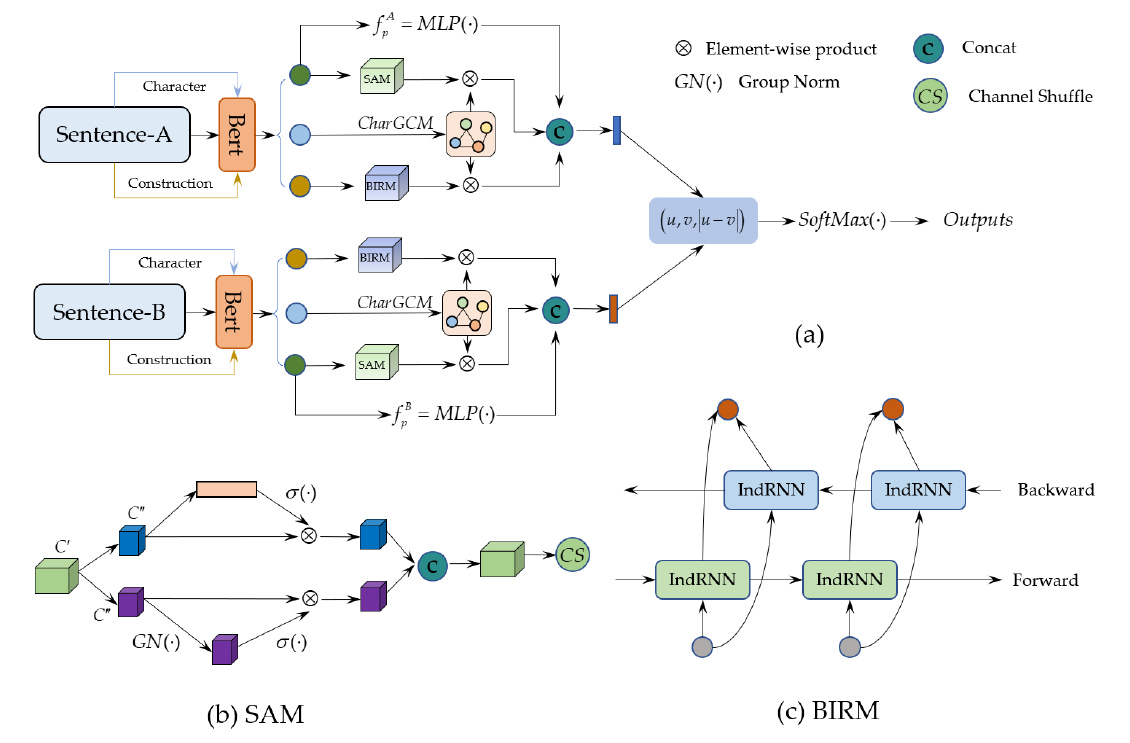
Figure 1. ( a ) The overall network structure of CharAs-CBert; ( b ) The slice attention module (SAM); ( c ) The bidirectional independent recurrent neural network module (BIRM). Where “ CharGCM ” indicates character graph convolution module; IndRNN indicates independent recurrent neural network; SoftMax ( · ) indicates classifier with softmax; σ ( · ) indicates the activation function of sigmoid ; MLP ( · ) indicates the operation of multilayer perceptron; C (cid:48) and C (cid:48)(cid:48) indicate the channels of input features and satisfies C (cid:48)(cid:48) = C (cid:48) . GN ( · ) indicates the operation of GroupNorm; ⊕ indicates 2 element-wise product operation. BERT indicates language model of pre-training; CS indicates channel shuffle operation; Backward indicates backward layers of BiIndRNN ; Forward indicates forward layers of BiIndRNN . f A p and f B p represent the a priori word vector feature obtained by the multi-layer perceptron ( MLP ( · ) ) of sentence A and sentence B,